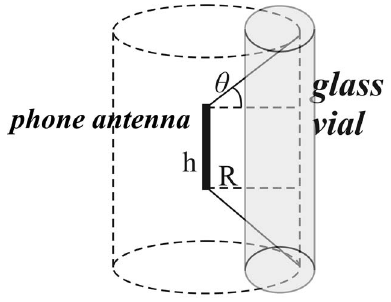
Figure 1. Experimental exposure graphic.